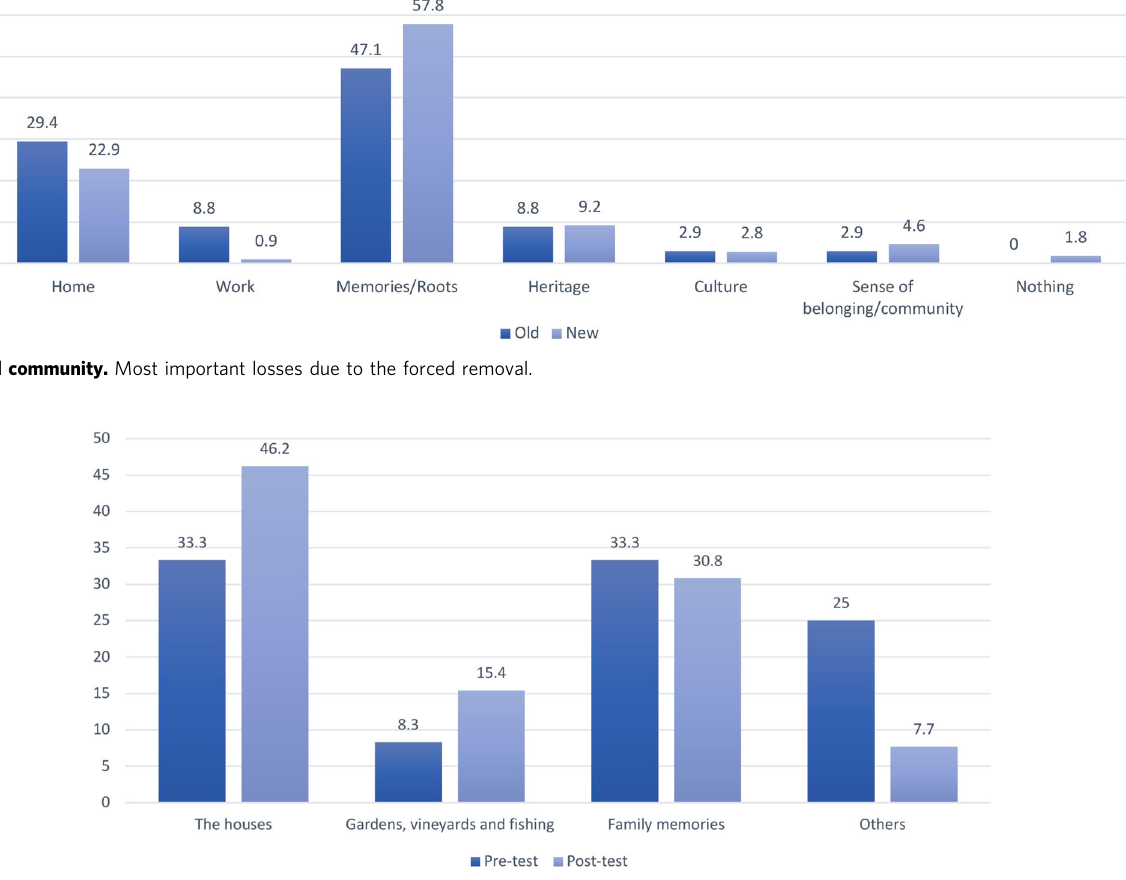
Fig. 2 School community. Most important losses due to the forced